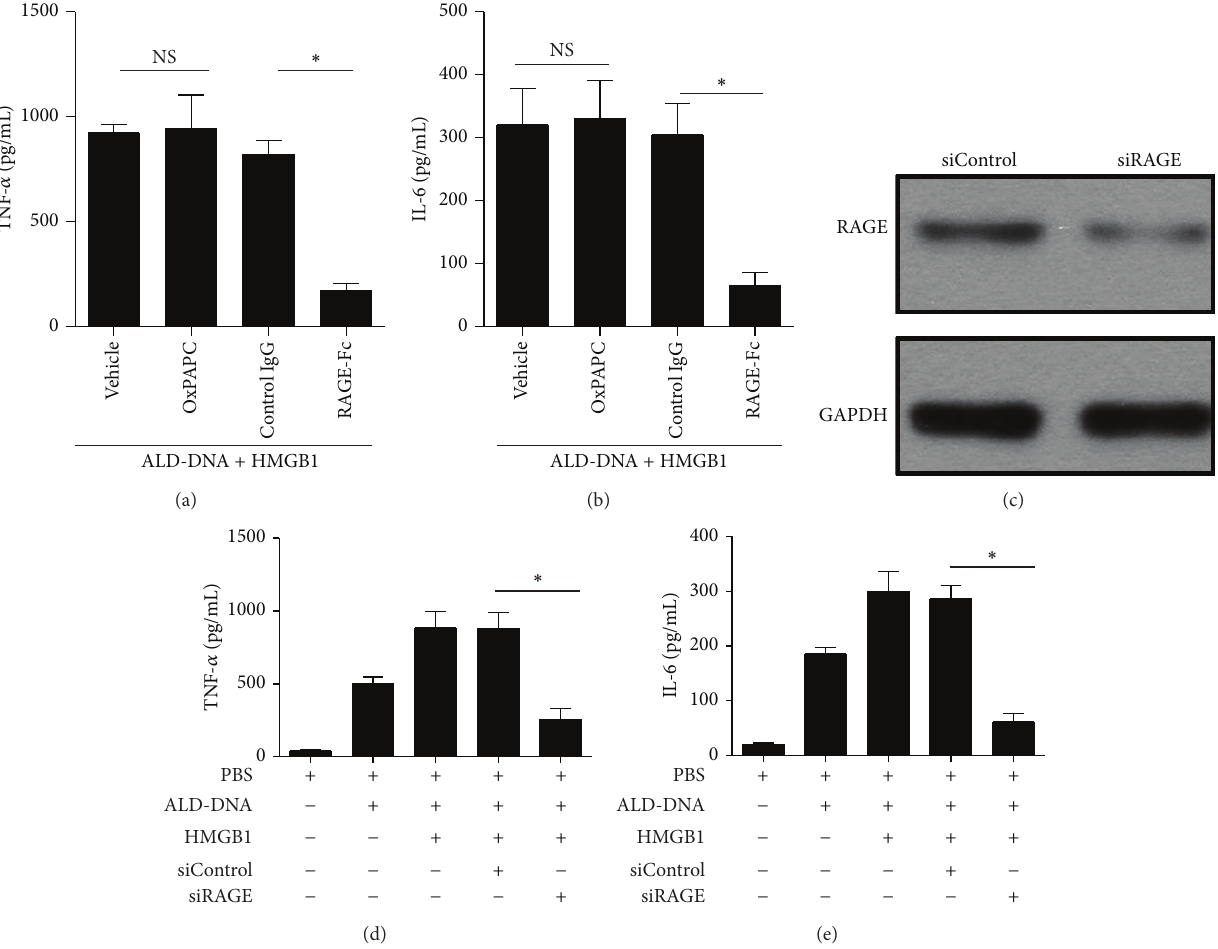
Figure 6: HMGB1-enhanced macrophage inflammatory response induced by ALD-DNA might be dependent on RAGE but not on TLR2 and TLR4. (a-b) RAW264.7 cells were transfected with pHMGB1, and then stimulated with ALD-DNA (50 𝜇 g/mL) in the presence of OxPAPC (30 𝜇 g/mL) or RAGE-Fc (10 𝜇 g/mL) for 24 h. The supernatants were collected and assayed for the concentrations of TNF- 𝛼 (a) and IL-6 (b) using ELISA. (c) Representative immunoblot of three independent experiments has shown the efficiency of RAGE knockdown. (d- e) RAW264.7 cells transfected with siRAGE and pHMGB1 were stimulated with 50 𝜇 g/mL of ALD-DNA for 24 h. The supernatants were collected and assayed for the concentrations TNF- 𝛼 (d) and IL-6 (e) using ELISA. ∗ 𝑃 < 0.05 .